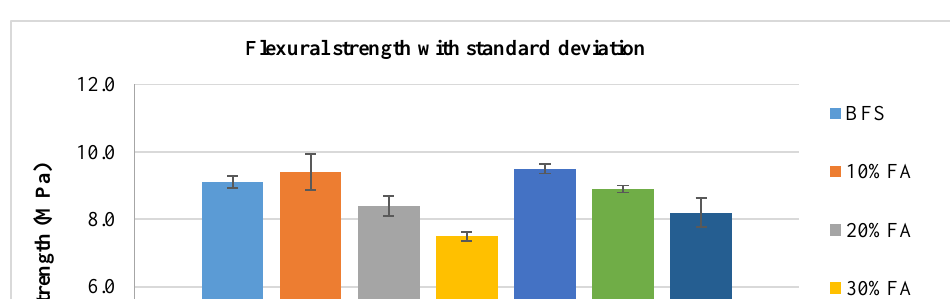
Figure 1. Compressive strength with standard deviation.